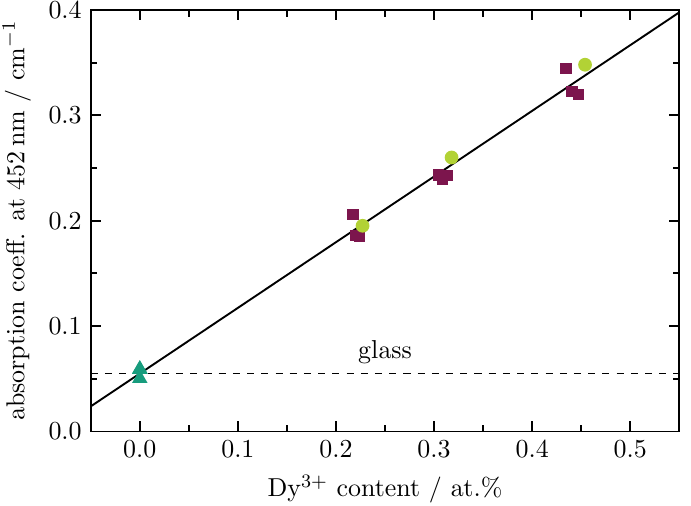
Figure 4. Total absorption coefficient at 452 nm versus Dy 3 + content for Dy 3 + (full circles) and Tb 3 + (full triangles) single-doped as well as Dy 3 + /Tb 3 + (full squares) double-doped BaB glasses. The solid line represents a least squares fitting to the experimental data. The glass background is indicated by the dashed